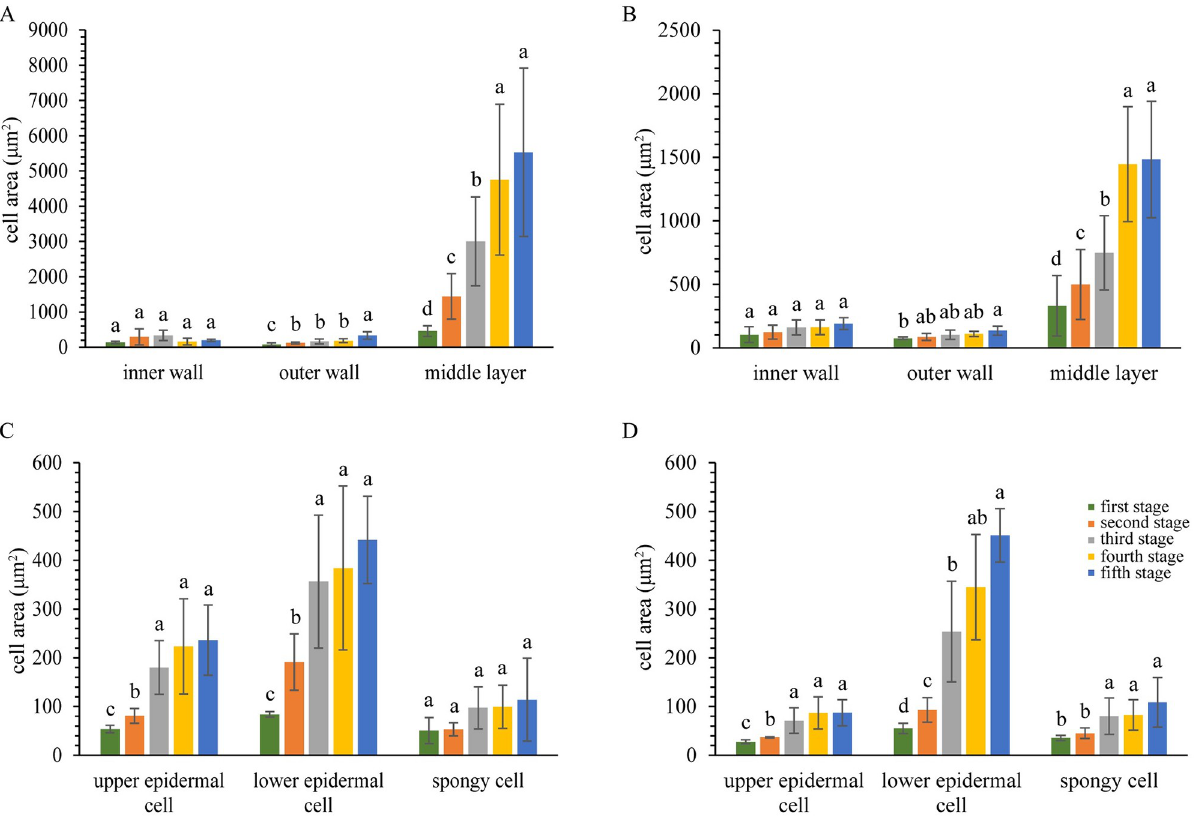
Fig 6. Cell area of fusiform and horned galls, and R . potaninii and R . chinensis leaves. (A) Cell area of fusiform galls. (B) Cell area of horned galls. (C) Cell area of R . potaninii leaves. (D) Cell area of R . chinensis leaves. P < 0.05. Lowercase letters indicate significant differences among five stages of each kind of cell, with average values decreasing from a to c, and no significant difference if they have the same letter.